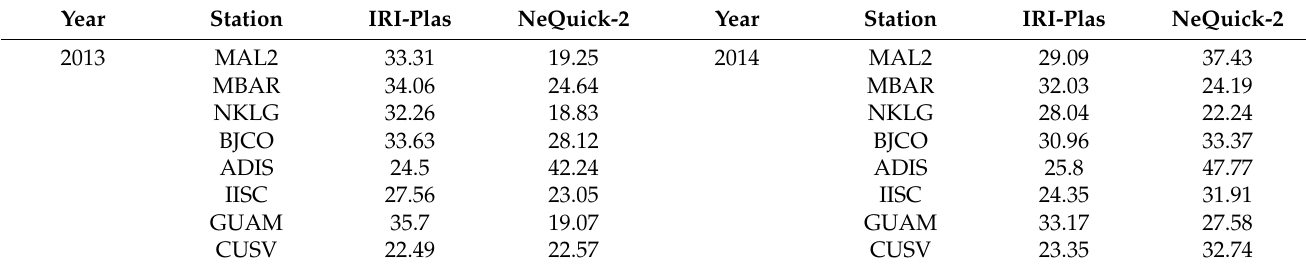
Table 4. Annual Percentage